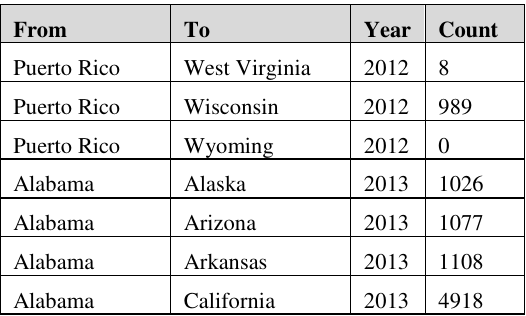
Table 1 Migration data input